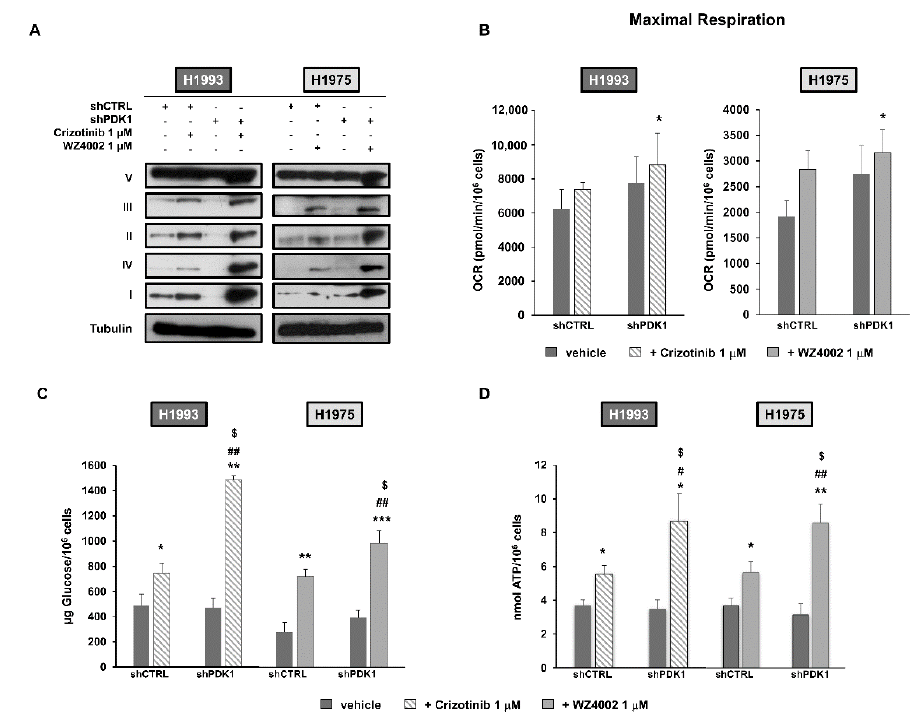
Figure 2. Combined effects of PDK1 knockdown and TKI treatment on OXPHOS. ( A ) Representative Western blotting of OXPHOS in whole cell lysates of shCTRL and shPDK1 H1993 and H1975 cells in basal conditions and after treatment with crizotinib or WZ4002, respectively. Tubulin served to ensure equal loading. ( B ) OCR measurements were obtained after FCCP stimulation in order to evaluate maximal respiration in shCTRL and shPDK1 H1993 and H1975 cells treated or not with crizotinib or WZ4002, respectively. Data are normalized for 10 6 cells and expressed as mean ± SD. The symbol * indicates statistically significant differences ( p < 0.05) versus treated shCTRL cells. ( C , D ) Concentration of residual glucose in conditioned media ( C ) and intracellular ATP levels ( D ) of untreated and treated cells. At least three independent assays were performed. Data are normalized for 10 6 cells and expressed as mean ± SE. The symbol * indicates statistically significant differences versus untreated shCTRL cells with * p < 0.05, ** p < 0.01 and *** p < 0.001; the symbol # indicates statistically significant differences versus untreated shPDK1 cells with # p < 0.05 and ## p < 0.01; the symbol $ indicates statistically significant differences versus treated shCTRL cells with $ p < 0.05. The uncropped Western Blot images can be found in Figure S7.